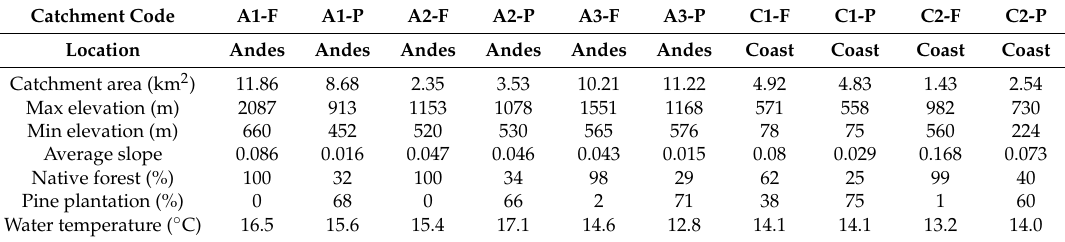
Table 2. Physical characteristics of the sampled catchment